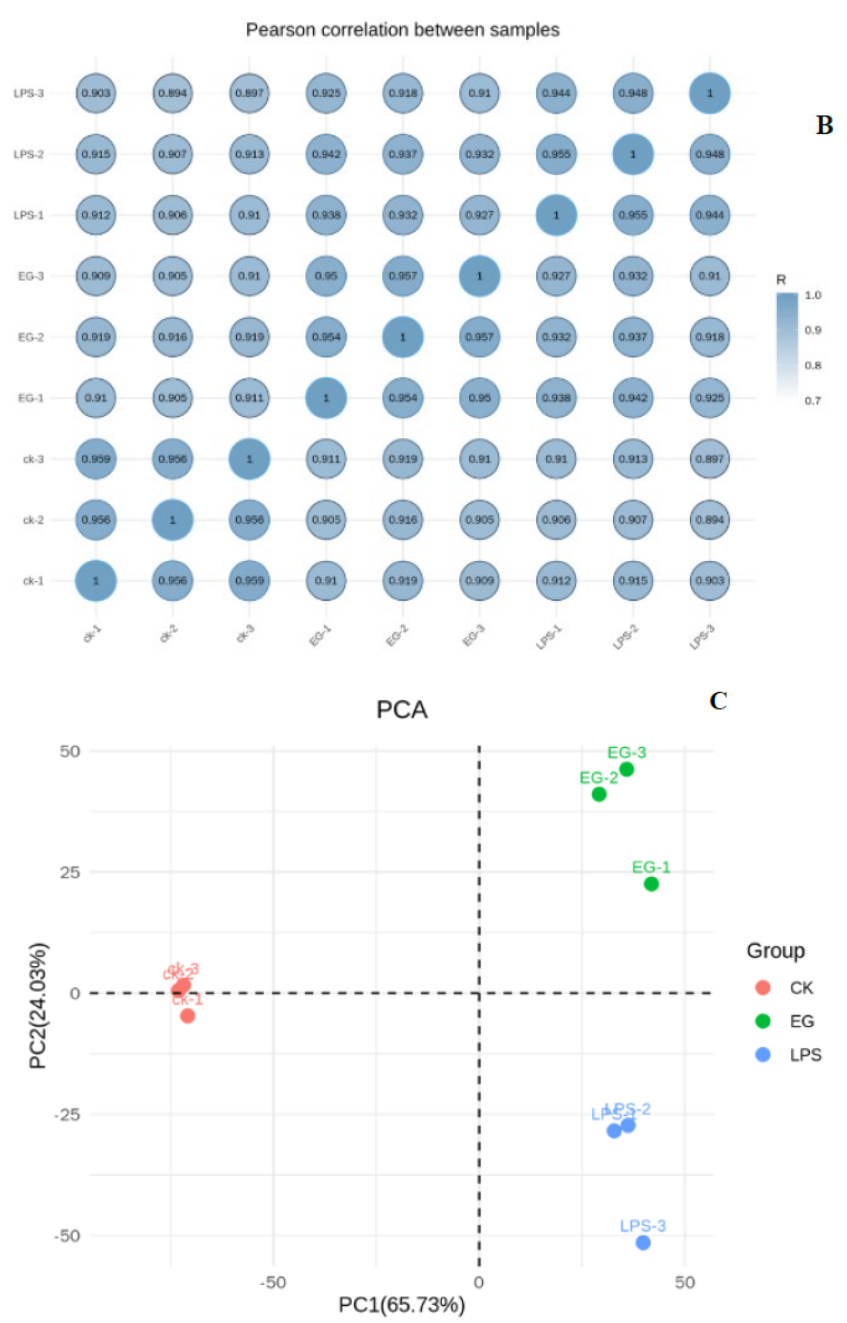
Figure 1. RNA-seq data–quality–assessment results. ( A ): Reads vs. reference genome comparison. Figure 1. RNA-−seq data-−quality−assessment results. ( A ): Reads vs. reference genome comparison. ( B ): Inter–sample–correlation–coefficient heat map. ( C ): Two–dimensional principal − component– ( B ): Inter−sample−correlation−coefficient heat map. ( C ): Two−dimensional principal−compo- analysis nent−analysis plots.